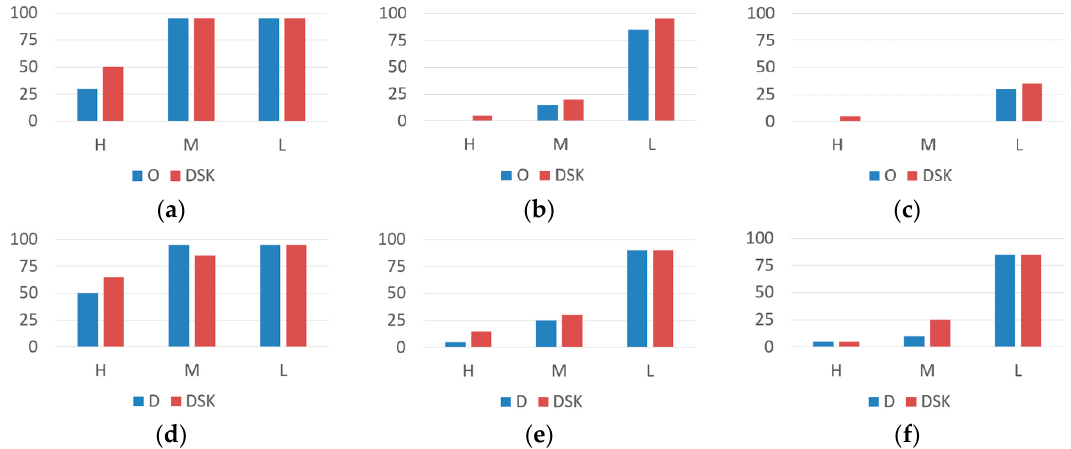
Figure 18. Comparisons of before and after applying the DSK. ( a ) 79-octahedron; ( b ) 32-octahedron; ( c ) 23-octahedron; ( d ) 79-dodecahedron; ( e ) 32-dodecahedron; ( f ) 23-dodecahedron.